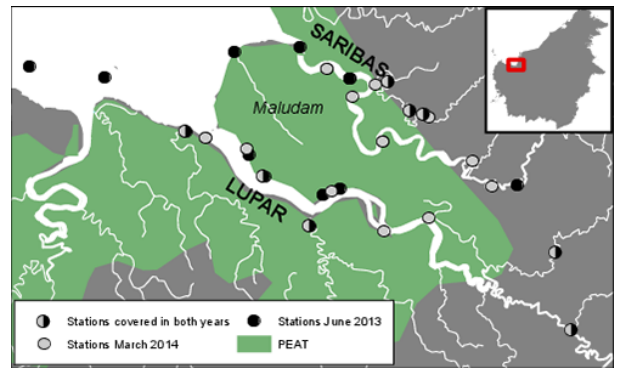
Figure 1. Map of the study area. The stations are indicated by the grey and black dots; peat soils (histosols) are indicated in green (as of FAO,